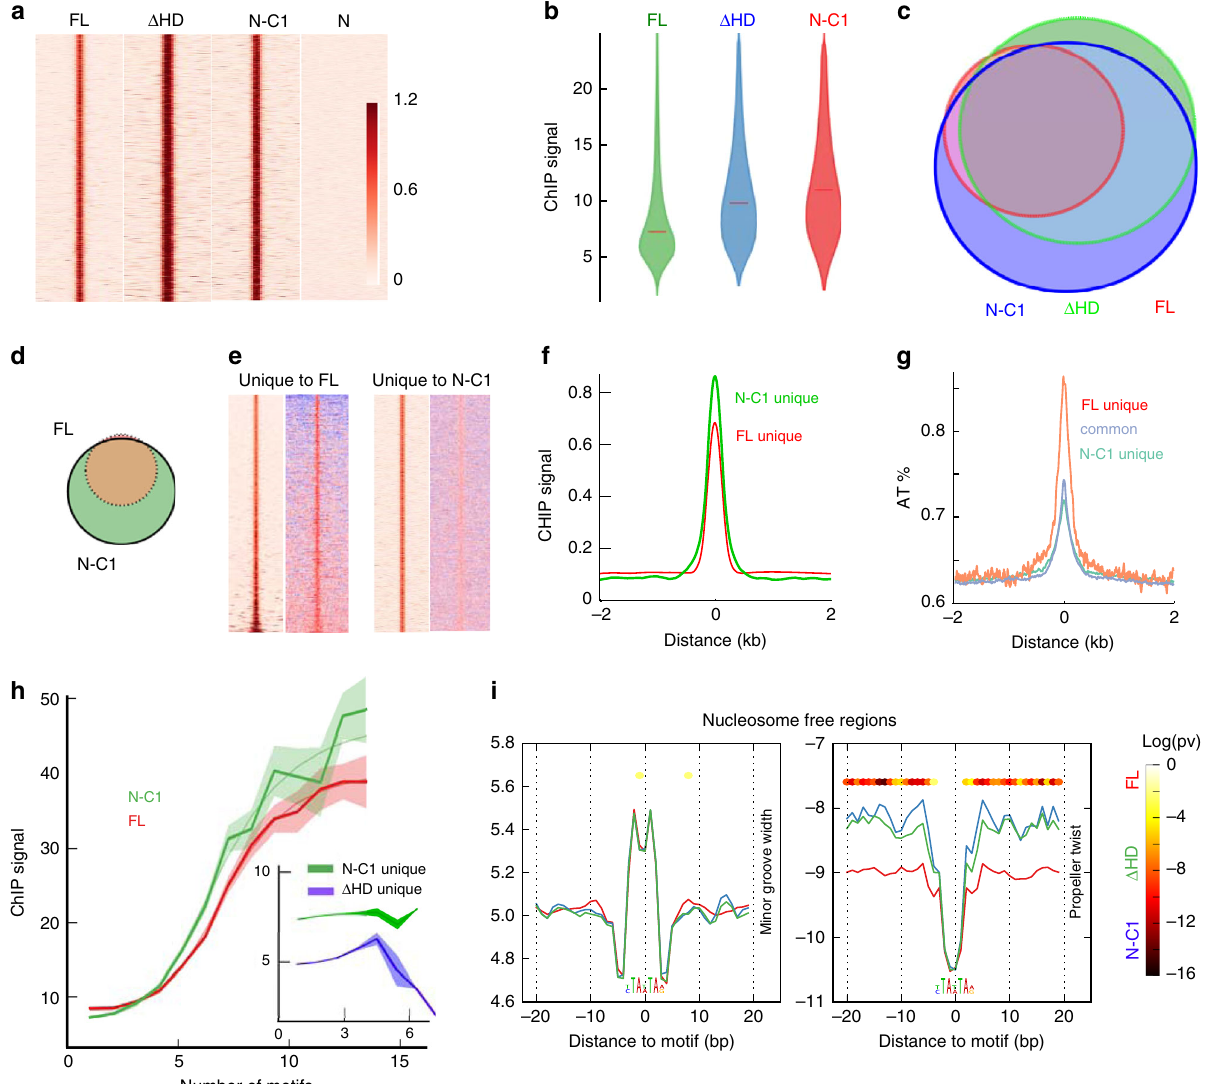
Fig. 8 Homeo domain is dispensable for high af fi nity binding but increases selection stringency. a Heatmap of ChIP-seq signals (read pileups) along a 4 kb window centered on binding peaks of different Satb1 domain constructs. Both N-C1 and Δ HD show higher signal enrichment at binding sites than FL Satb1. The dimerization domain N on its own shows no consistent signal enrichment. b Violin plots showing the distribution of the peak signal strengths for 3 different Satb1 constructs (Median peak strengths are shown as horizontal lines). c Venn diagram showing binding site overlap between all 3 domain constructs. d Venn diagram of FL versus N-C1 binding sites. N-C1 binds nearly all (~97%) of all FL binding sites and more than as many sites exclusively. e Heatmap of ChIP-seq signals (read pileups) (left column) and AT percentage (right column) of binding sites unique to FL Satb1 and N-C1. f, g Average plot of ChIP-seq signals ( f ) and AT percentage ( g ) along a 4 kb window across the binding sites that are exclusively bound by FL Satb1 or N-C1. h N-C1 and Δ HD bind cooperatively to sites that are common with FL Satb1. However, sites exclusively bound by N-C1 and N-C1-2 show no such cooperative pattern (inset). Error envelopes are plotted using standard error of the mean. i Distinct DNA-shape features help de fi ne FL Satb1 and N-C1 binding. Line plots showing average of MGW and ProT values across 40 bp windows centered on consensus sites bound by FL Satb1 and sites bound exclusively by N-C1 ( n = 971) and Δ HD ( n = 976) in nucleosome free regions. p -values in i are obtained using Mann – Whitney U test. Source data are provided as a Source Data fi